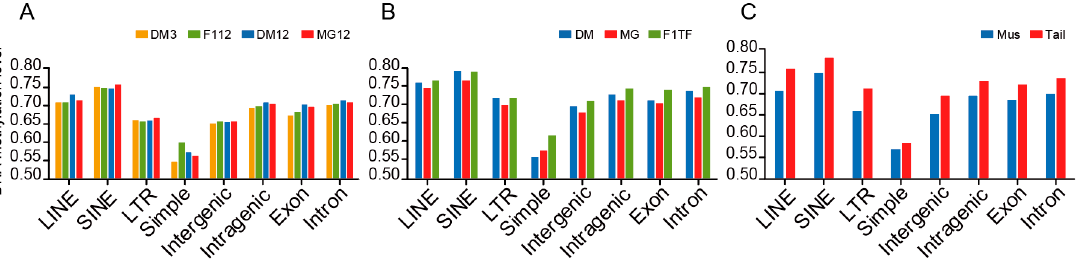
Figure 4. DNA methylation dynamics of repeat elements, intergenic regions, and intragenic regions. DNA methylation dynamics of ( A ) muscle tissue, and ( B ) tail-fat tissue. ( C ) Comparison of DNA methylation levels between muscle tissue and tail-fat tissue.